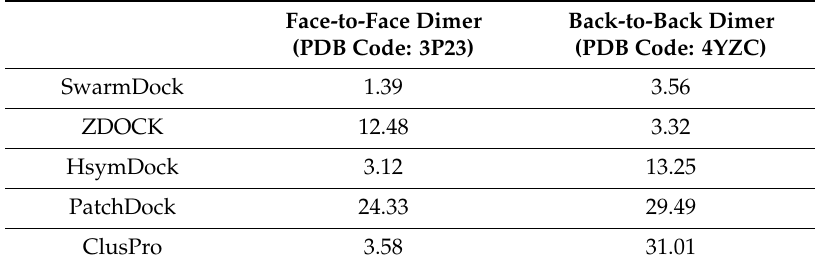
Table 1. The RMSD a results (in angstrom) of five di ff erent protein–protein docking approaches to reproduce the known IRE1 dimer complexes.